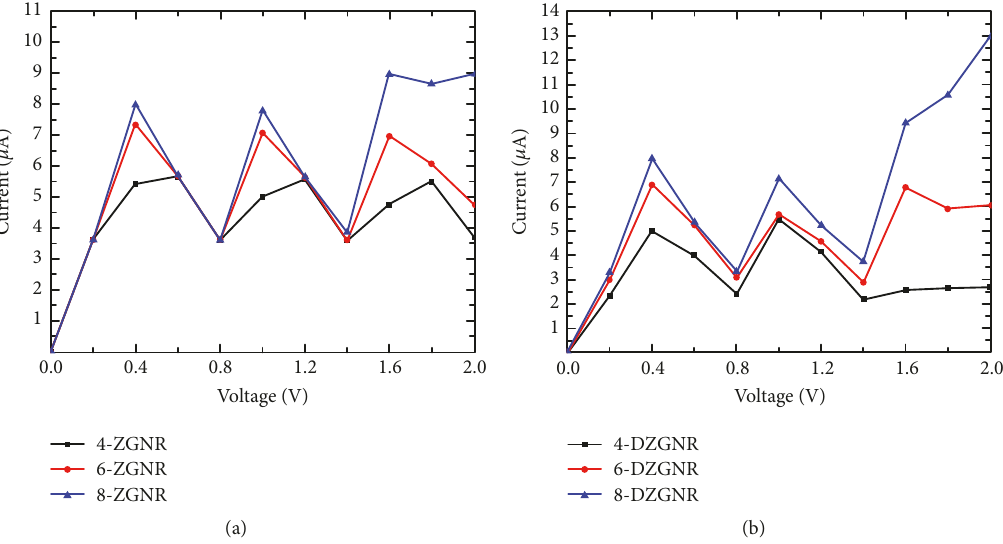
Figure 6: Calculated I-V curves for six structures: (a) 4-ZGNR, 6-ZGNR, and 8-ZGNR and (b) 4-DZGNR, 6-DZGNR, and 8-DZGNR.